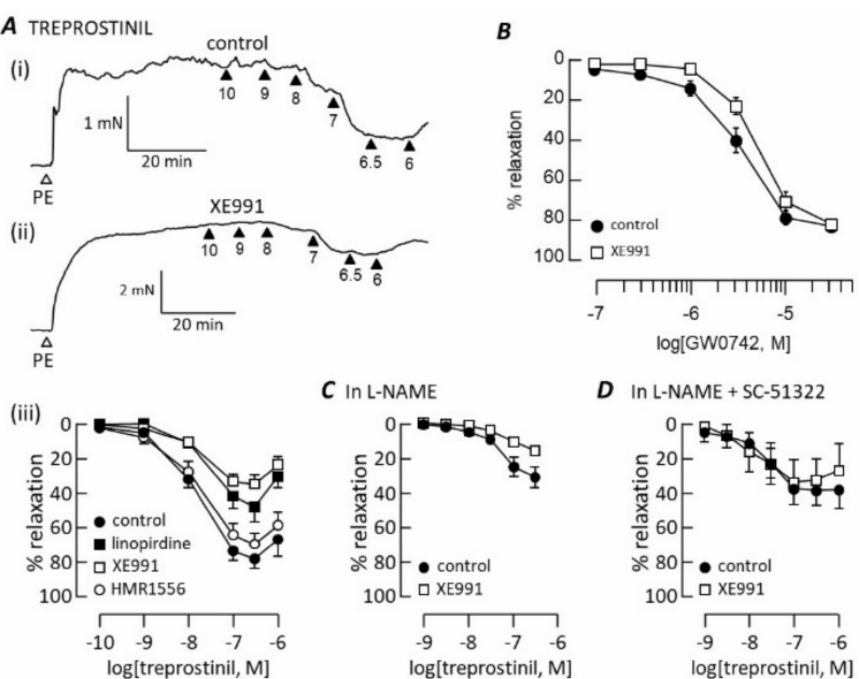
Figure 5. Kv7 channel blockers inhibit treprostinil-induced relaxation. Traces illustrate contrac- tion to 1 µ M phenylephrine (PE) followed by relaxation after cumulative addition of 0.1 nM–1 µ M treprostinil in control conditions ( A ( i )) and after adding 1 µ M XE991 ( A ( ii )). Arrowheads in- dicate -log[treprostinil]. Concentration–relaxation curves ( A ( iii )) are compared in control con- ditions and after adding a Kv7 channel blocker (1 µ M), as indicated ( n = 6 in each condition). ( B ) Concentration–response curves to GW0742 in the absence and presence of 1 µ M XE991 ( n = 8). Treprostinil concentration–response curves are compared in the absence and presence of 1 µ M XE991 after blocking NO synthase with 100 µ M L-NAME ( C ; n = 8) and with additional block of EP receptors with 10 µ M SC-51322 ( D ; n =